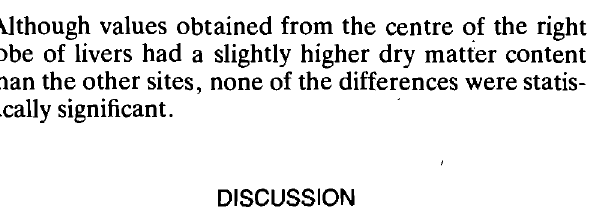
Table 3: THE PERCENTAGE DRY MATTER OF LIVERS Trial Dry matter % SO